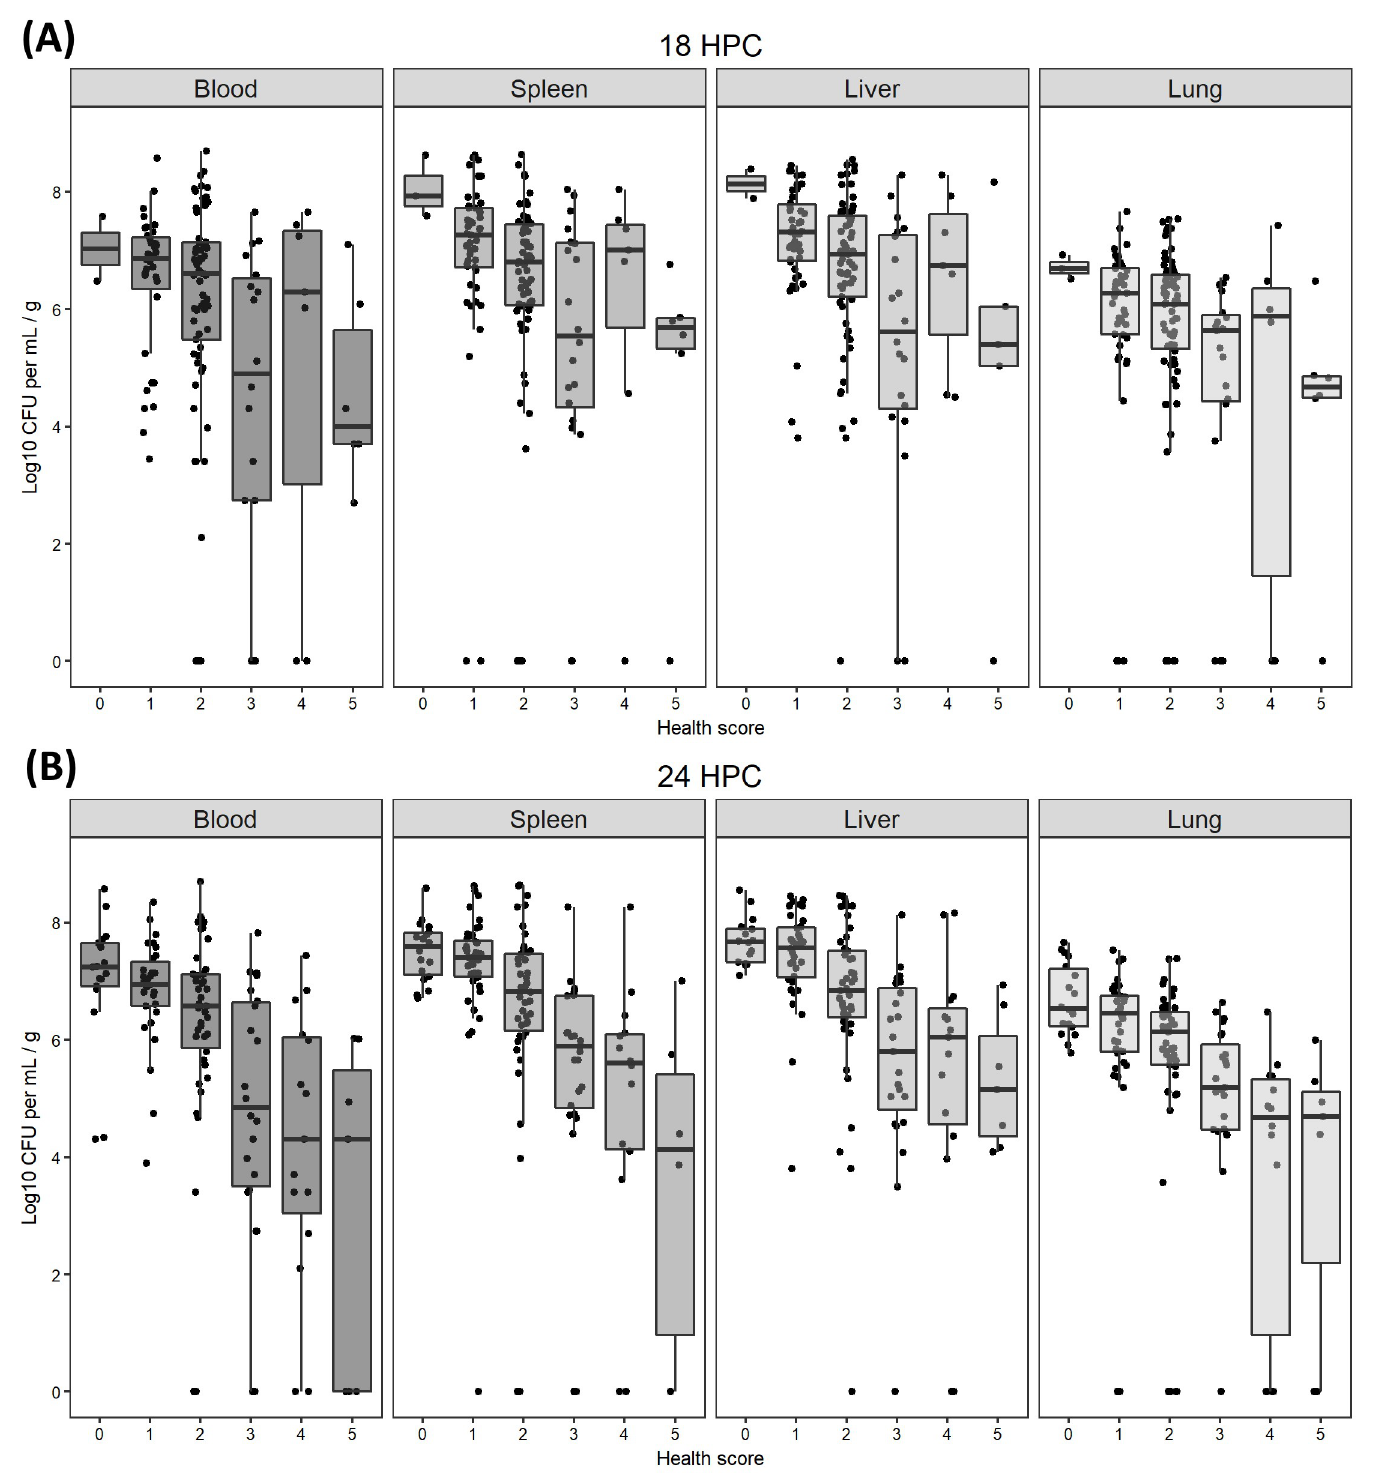
Fig 3. Health scores at 18 and 24 HPC are related to bacterial load at 24 HPC. (A) A Kruskal-Wallis comparison of score 18 hours post challenge (HPC) with bacterial load in whole-blood and tissues showed a significant effect (Bonferroni-adjusted p-values < 0.001) indicating score at 18 HPC was related to the bacterial load measured in tissues of the same animals collected 6 hours later (24 HPC). (B) A significant effect was also attained at 24 HPC (Bonferroni-adjusted p-values < 0.001) demonstrating the relationship between health scores and bacterial load across all biological compartments.